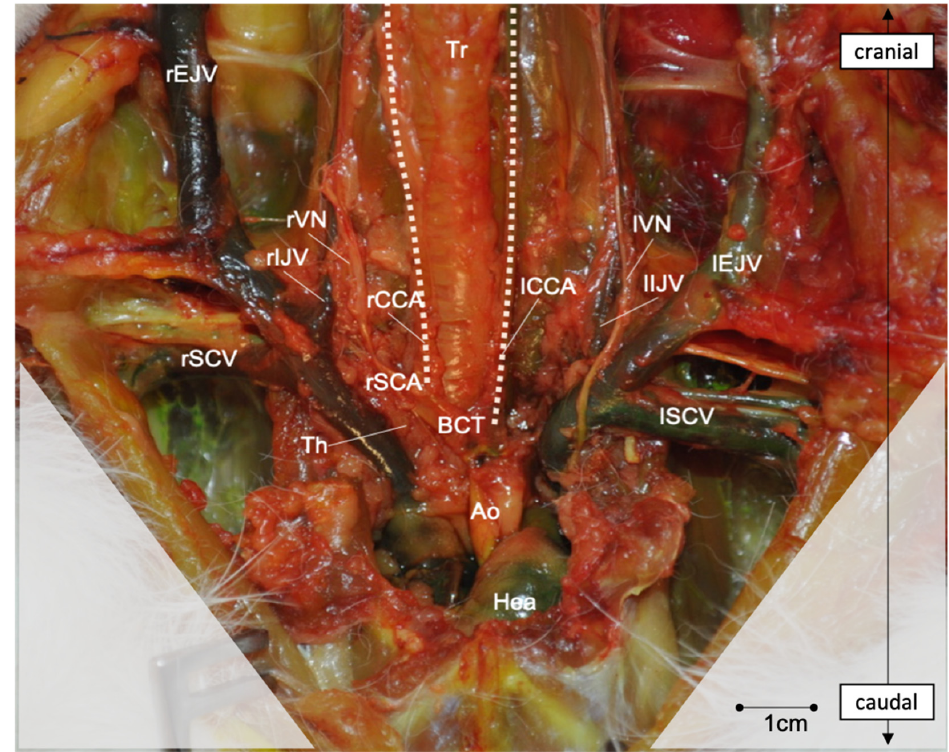
Figure 5. Frontal overview of the deep neurovascular structures of the neck after resection of the muscle layers and cranial part of the thoracic cage. SCM, STM, SHM, DPM, TPM, and SSM, as well as the clavicle, the three first ribs and the cranial third of manubrium sterni were removed. Subcutaneous fat, thymus and pericardial fat were dissected and removed to free the vessels and nerves. The dotted lines highlight the course of the rCCA and lCCA. Abbreviations: Tr—trachea; Hea—heart; Th—thymus; SCM—sternocephalicus muscle; STM—sternothyroid muscle; DPM—descending pectoral muscle; TPM—transverse pectoral muscle; SSM—sternoscapular muscle; rEJV—right external jugular vein; lEJV—left external jugular vein; rIJV—right internal jugular vein; lIJV—left internal jugular vein; rSCV—right subclavian vein; lSCV—left subclavian vein; Ao—aorta; BCT—brachiocephalic trunk; lCCA—left common carotid artery; rCCA—right common carotid artery; lVN—left vagal nerve; rVN—right vagal nerve.